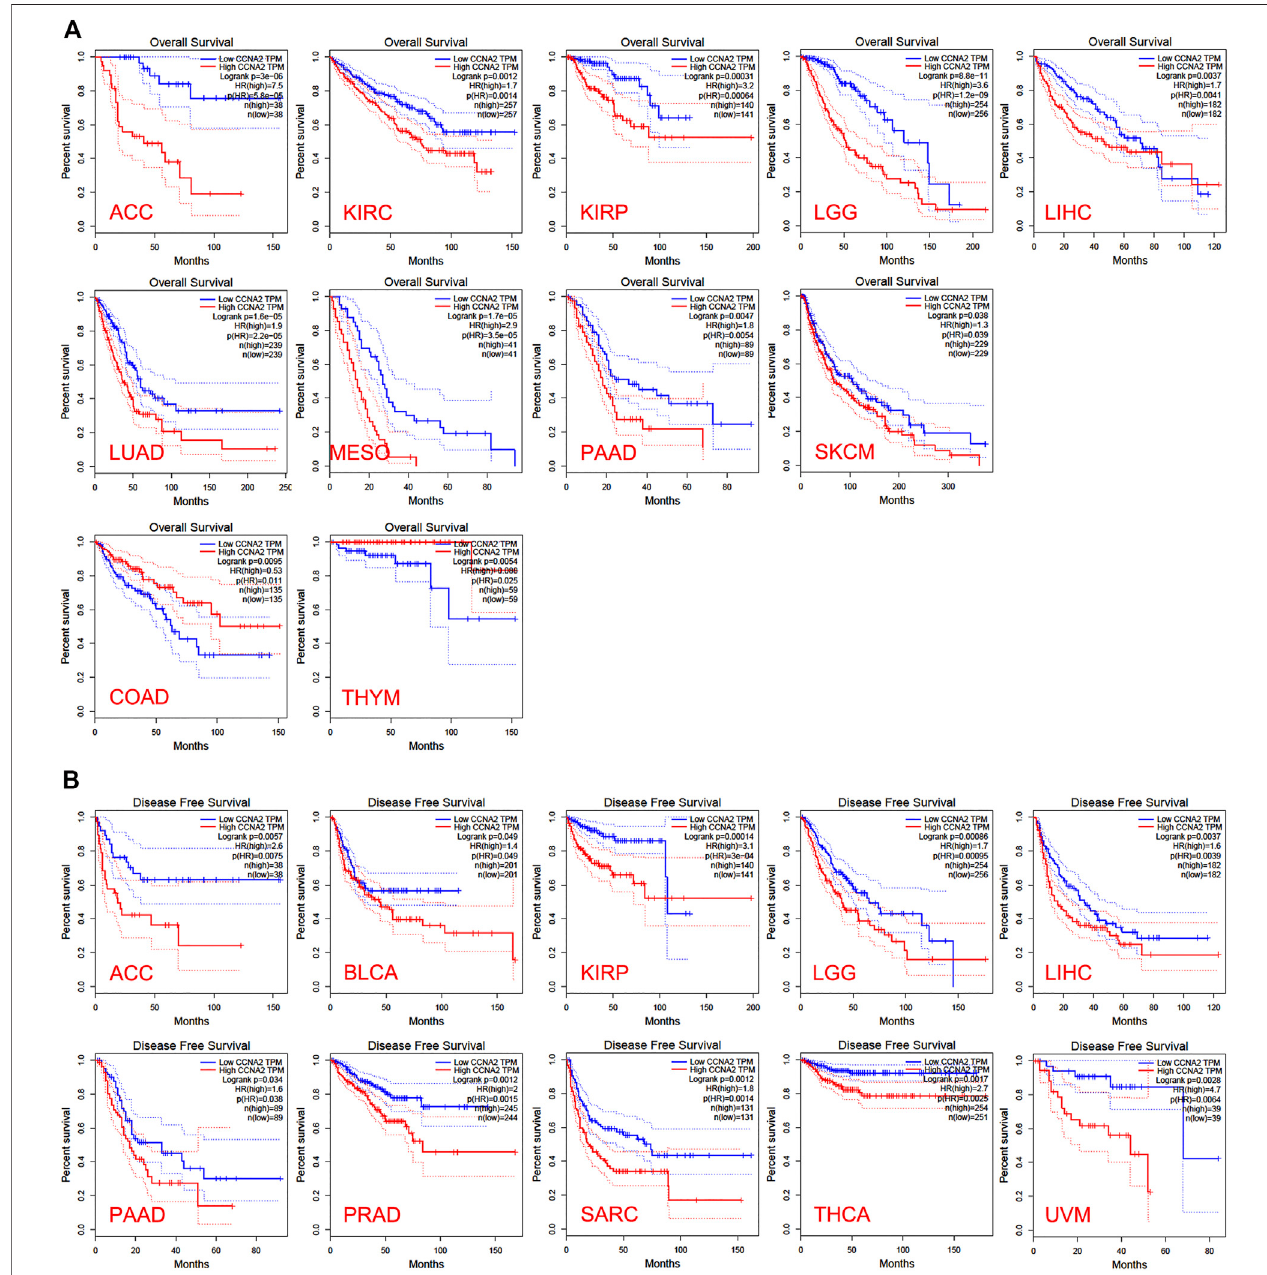
FIGURE 2 | Overall survival analysis (A) and disease-free survival analysis (B) based on the CCNA2 expression in various cancers.